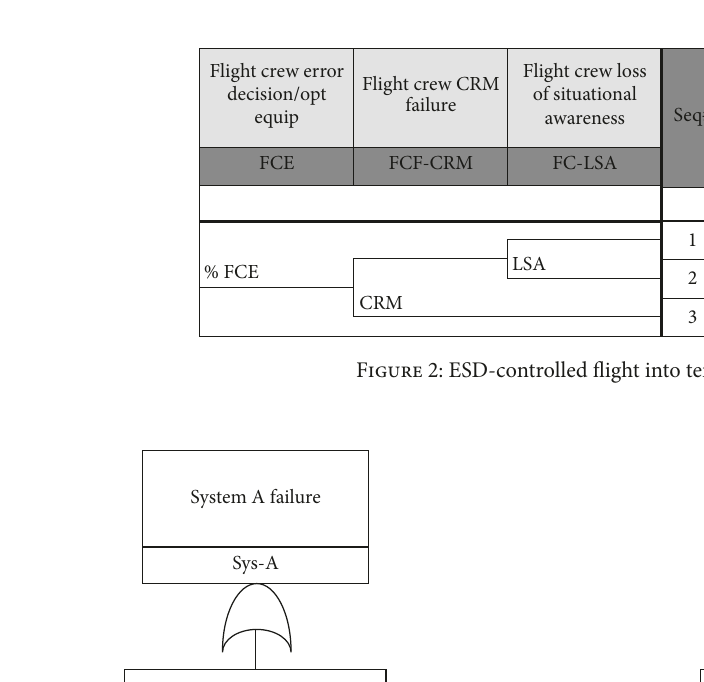
Figure 1: ESD used for LOC-I during aircraft maneuvering.